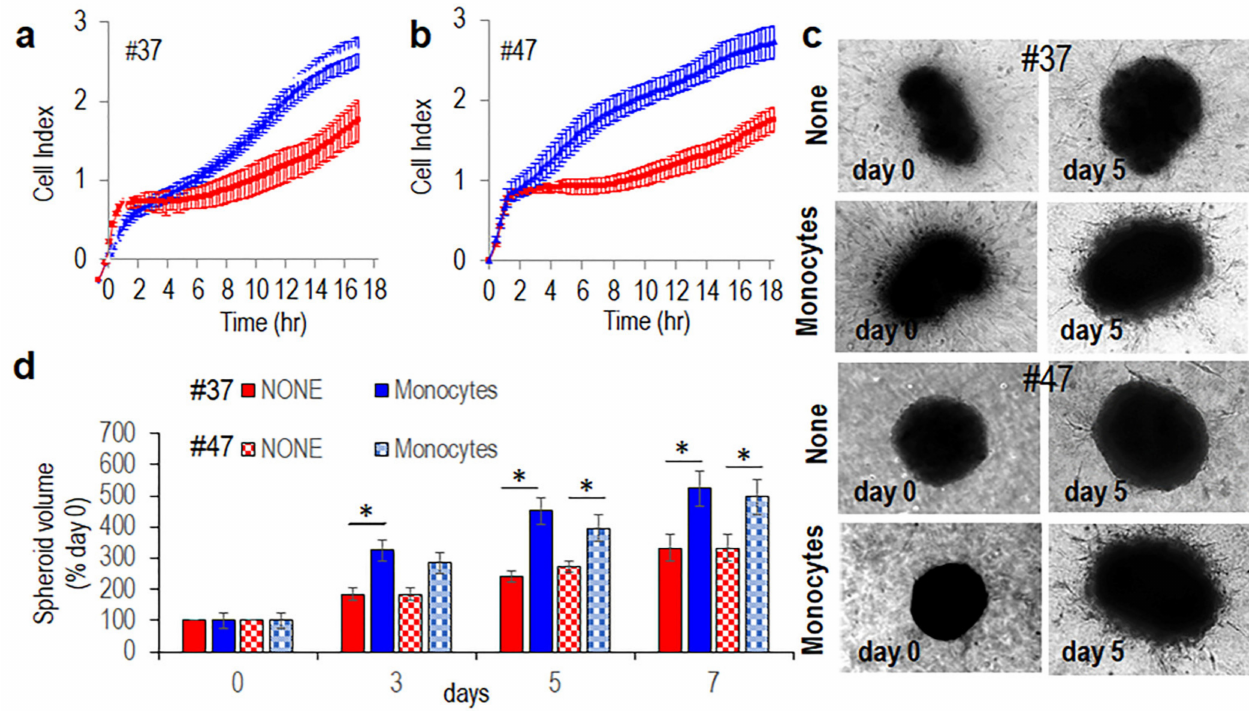
Figure 6. Monocytes pre-exposed to MPLS cells increases spreading of primary MLPS cells into matrices. ( a , b ). Primary #37 ( a ) and #47 ( b ) MLPS cells were suspended in CM from human monocytes pre-co-cultured with #37 and #47 (MLPS cells respectively (blue curves), or control monocytes (CTRL CM, red curves) and seeded onto matrigel-coated E-plates with serum added to a 10% final concentration. Matrigel invasion was monitored for 18 h by the RTCA xCELLigence technology. Data represent mean ± SD from a quadruplicate experiment representative of 2 replicates. ( c , d ). Spheroids containing primary #37 ( c ) or #47 ( d ) MLPS cells were embedded in the collagen/fibroblast mixture without (None), or with human monocytes. At the indicated times, images ( c ) were acquired at 50 × magnification. ( d ) Time-dependent increase of spheroid size assessed by using the formula: V = D(d) 2 /2, where D and d are the major and the minor spheroid diameter, respectively. Data expressed as percentage of volumes assessed at time zero are the mean ± SD of two independent experiments, performed in duplicate. Statistical significance with * p <